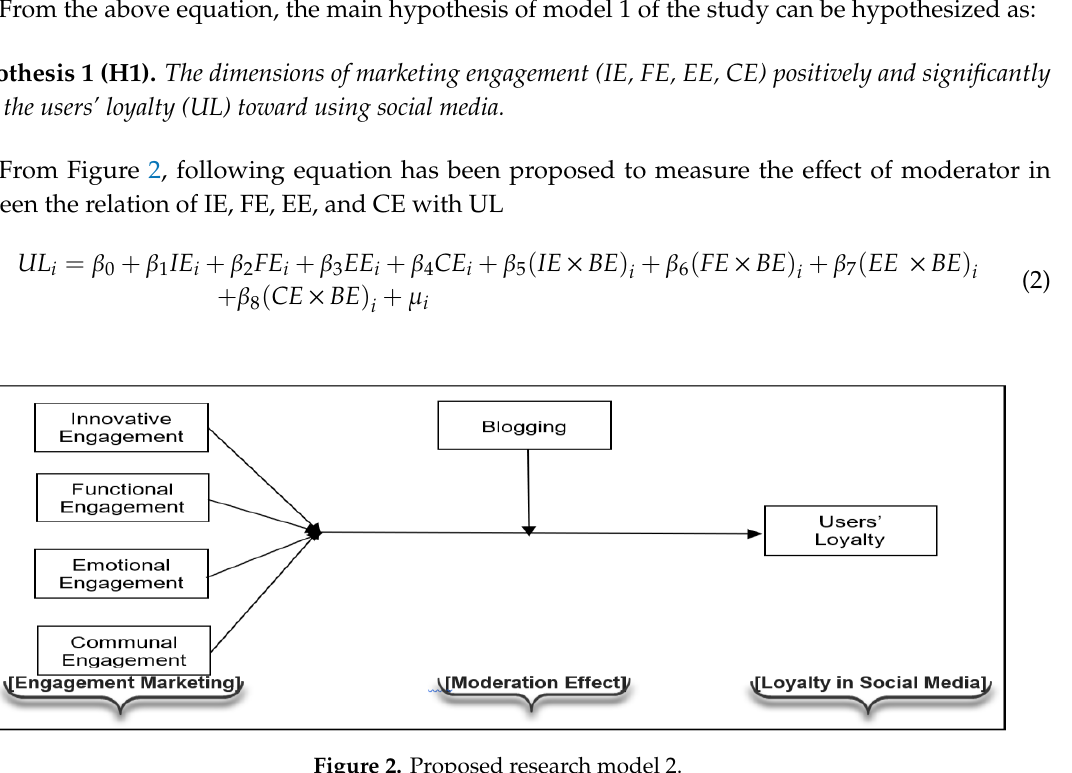
Figure 2. Proposed research model 2.